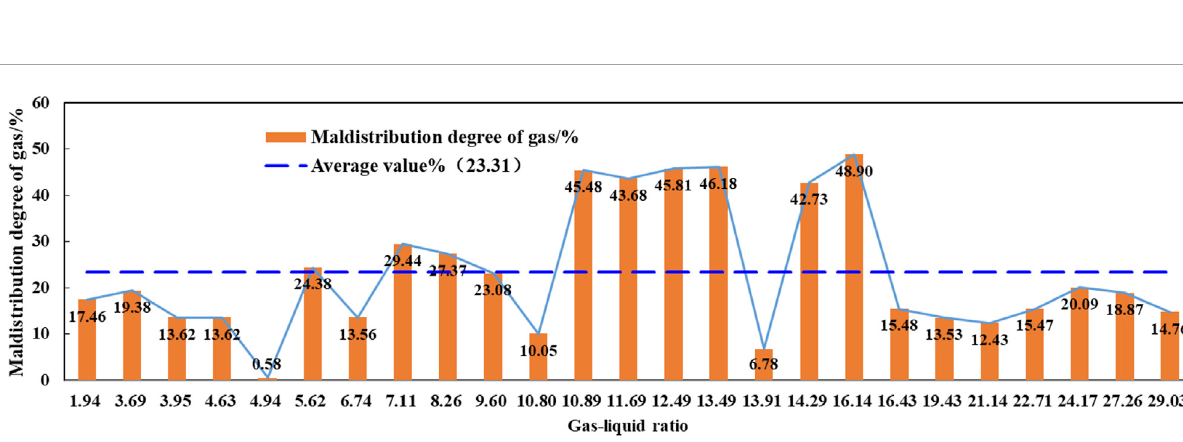
FIGURE 11 Histogram of gas – liquid ratio and maldistribution degree of gas in slug fl ow in horizontal manifold with fl ute pipes (liquid injection volume 0.35L/s+0.65L/s).